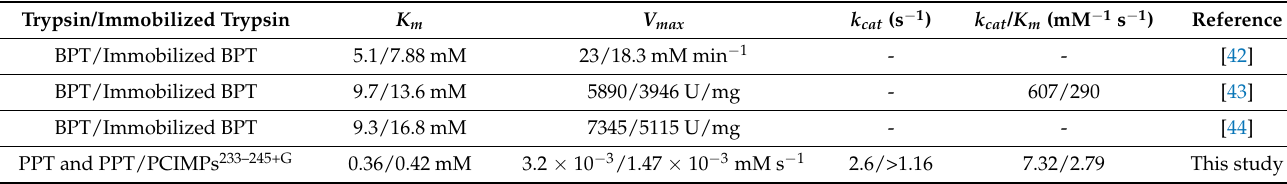
Table 3. Comparison studies of proposed PPT/PCIMPs with other